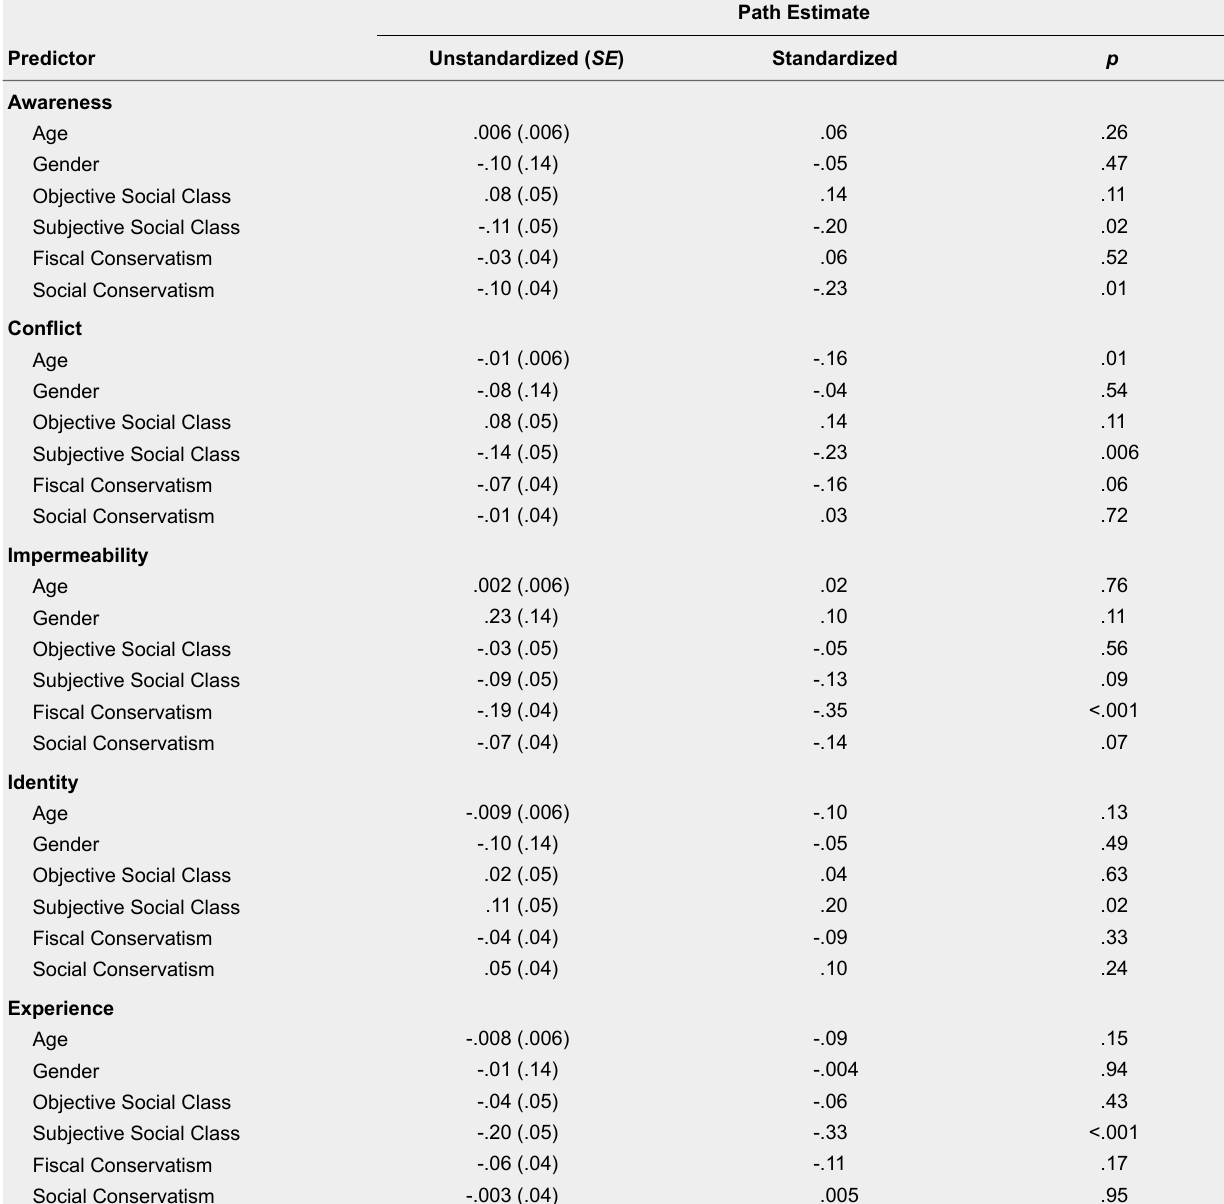
Estimated Parameters of the Structural Model Regressing Class Consciousness Dimensions Onto Age, Gender, Objective and Subjective Social Class, Fiscal Conservatism, and Social